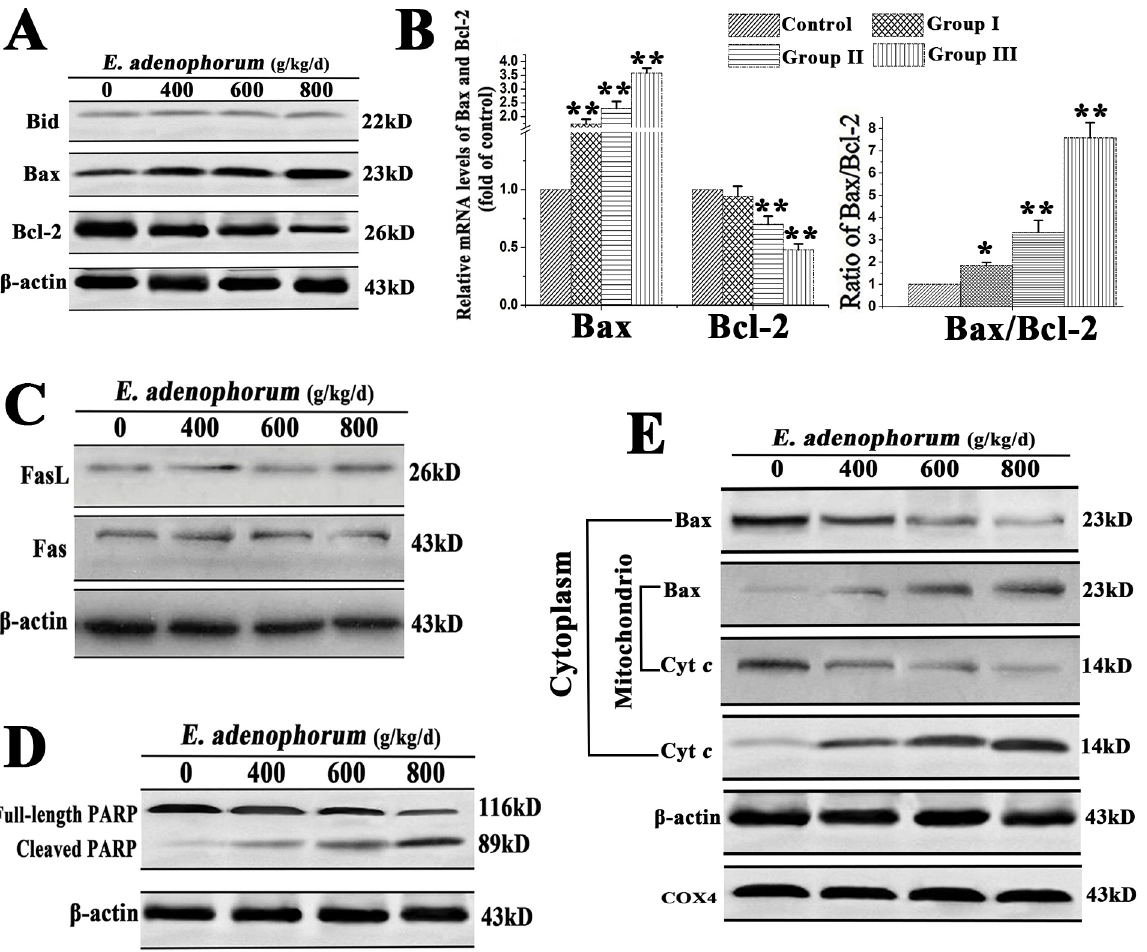
Fig 4. The renal cells apoptosis induced by E . adenophorum was mediated by mitochondrial pathway. (A) E . adenophorum did not promote the cleavage of Bid, but increased the protein levels of Cyt c and Bax, and decrease the protein level of Bcl-2. (B) E . adenophorum decreased ralative mRNA level of Bcl-2, but increased the level of Bax, resulting in the change of Bax/Bcl-2. (C) The protein levels of Fas or FasL measured by western blot did not reveal any changes. (D) The renal cells were subjected to western blot analysis to detectfull-length and cleaved PARP. (E) E . adenophorum induced Bax translocation and Cyt c release. The cytosolic and mitochondrial fraction proteins were collected and then detected by western blot. COX 4 and β -actin were used as internal controls for the mitochondrial fractions and the cytosolic fraction,